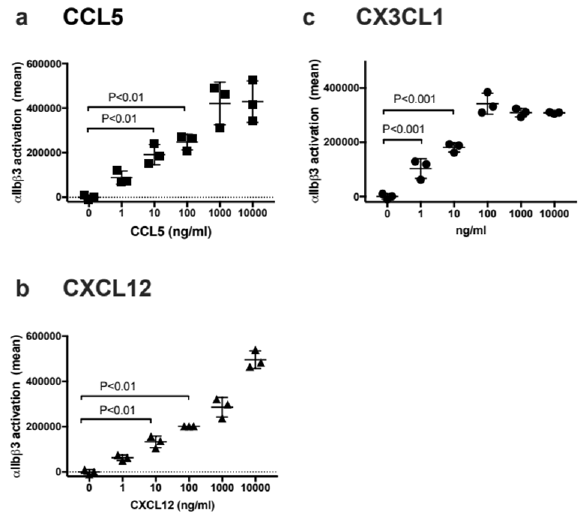
Figure 7. Dose-response of chemokine-induced activation of cell-surface αIIbβ3. αIIbβ3 -CHO cells were incubated with chemokines ( a ) CCL5, ( b ) CXCL12, or ( c ) CX3CL1 at indicated concentrations for 30 min on ice and then incubated with FITC-labeled γ C390–411 for 30 min at room temperature. The cells were washed with PBS/0.02% BSA and analyzed by flow cytometer. Data are shown as mean fluorescence intensity +/ − SD in triplicate experiments.